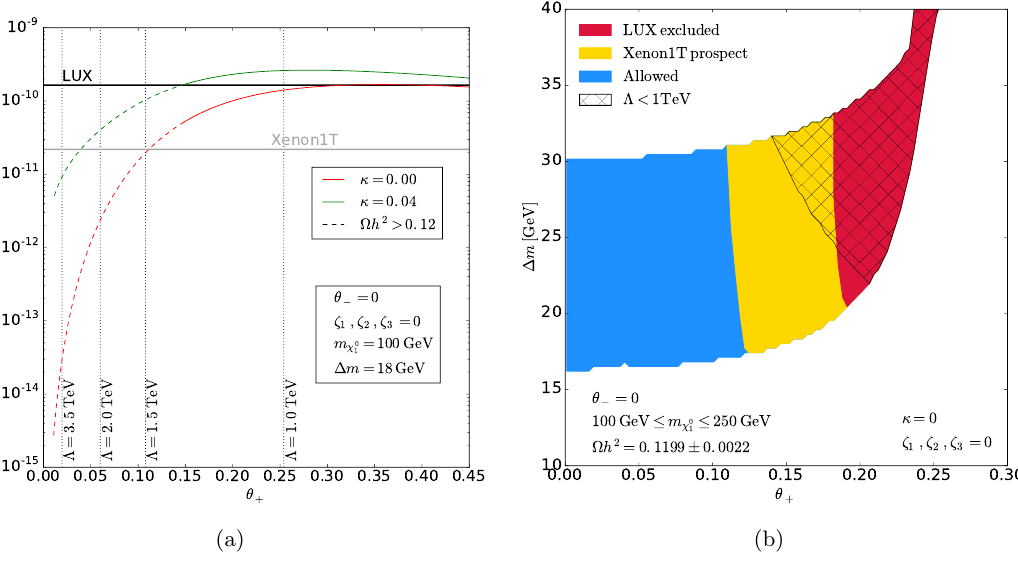
Figure 5 . Same as (cid:12)gure 2 but for the quadruplet model at (cid:18) (cid:0) = 0. Left panel: the model is excluded by direct detection for all but small (cid:20) . 0 : 04. Right panel: current and projected exclusion bounds at (cid:20) = 0. The hatched region corresponds to large mixing angles requiring a scale (cid:3) < 1 TeV, where our e(cid:11)ective theory can no longer be trusted.